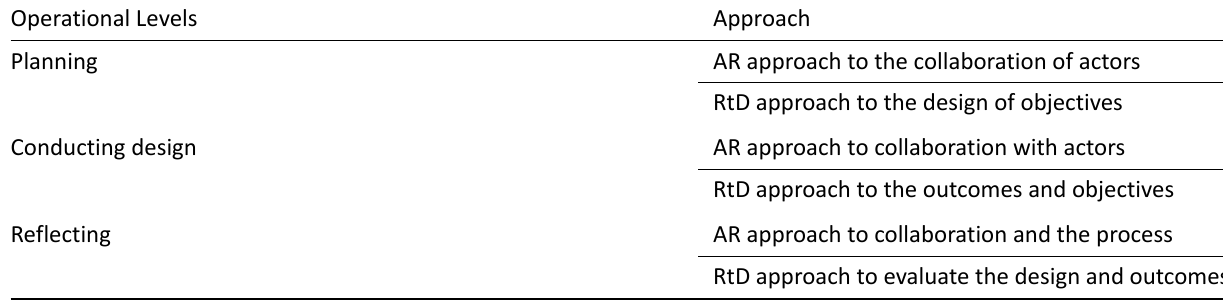
Table 1. ARtD steps were undertaken to plan, conduct, and reflect upon the co‐design process. Operational